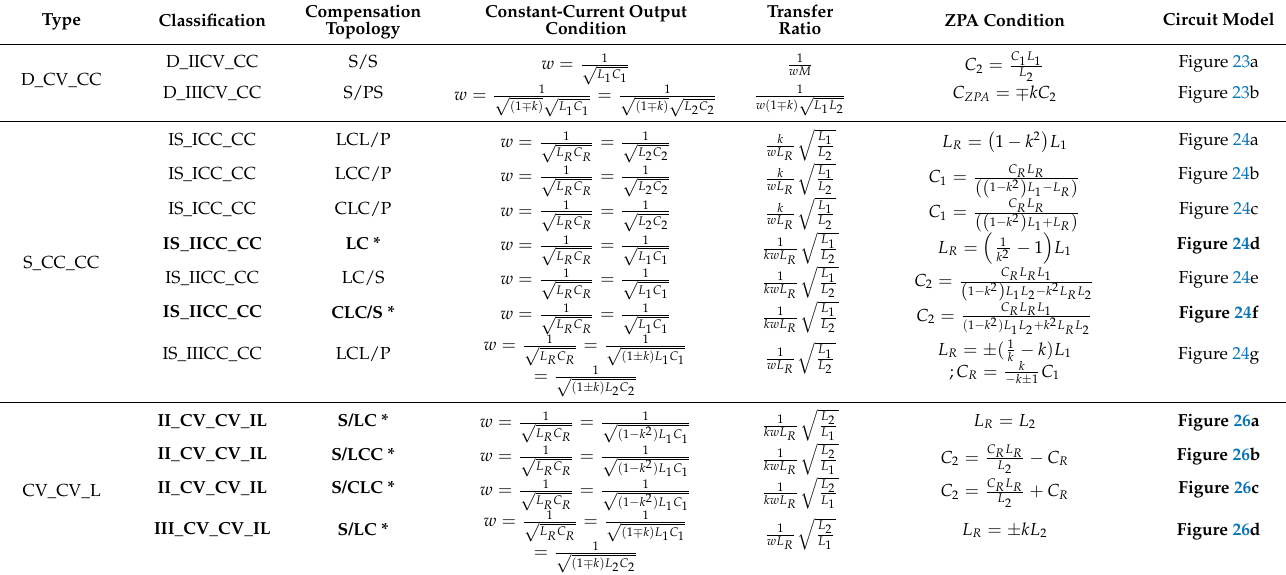
Table 3. The design results for voltage-fed compensation circuit with load-independent CC output at ZPA frequencies.